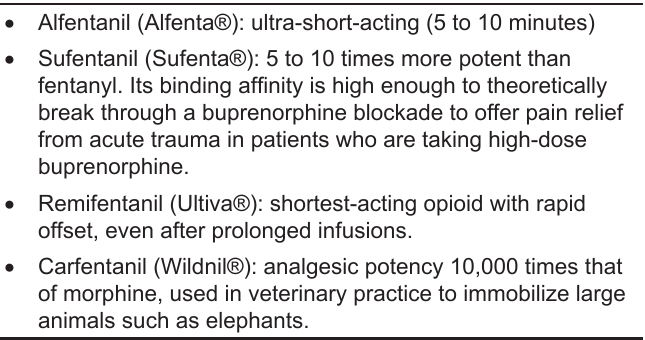
Table 7 . Analogs of